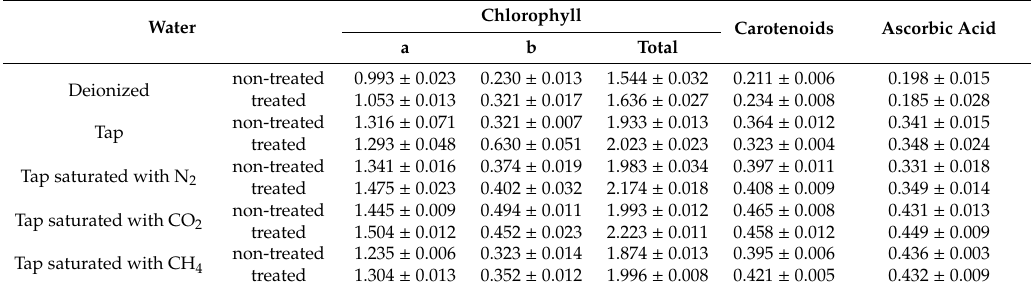
Table 3. E ff ect of LPGP-treated water on the content of the chlorophyll, carotenoids and ascorbic acid in watered cress.